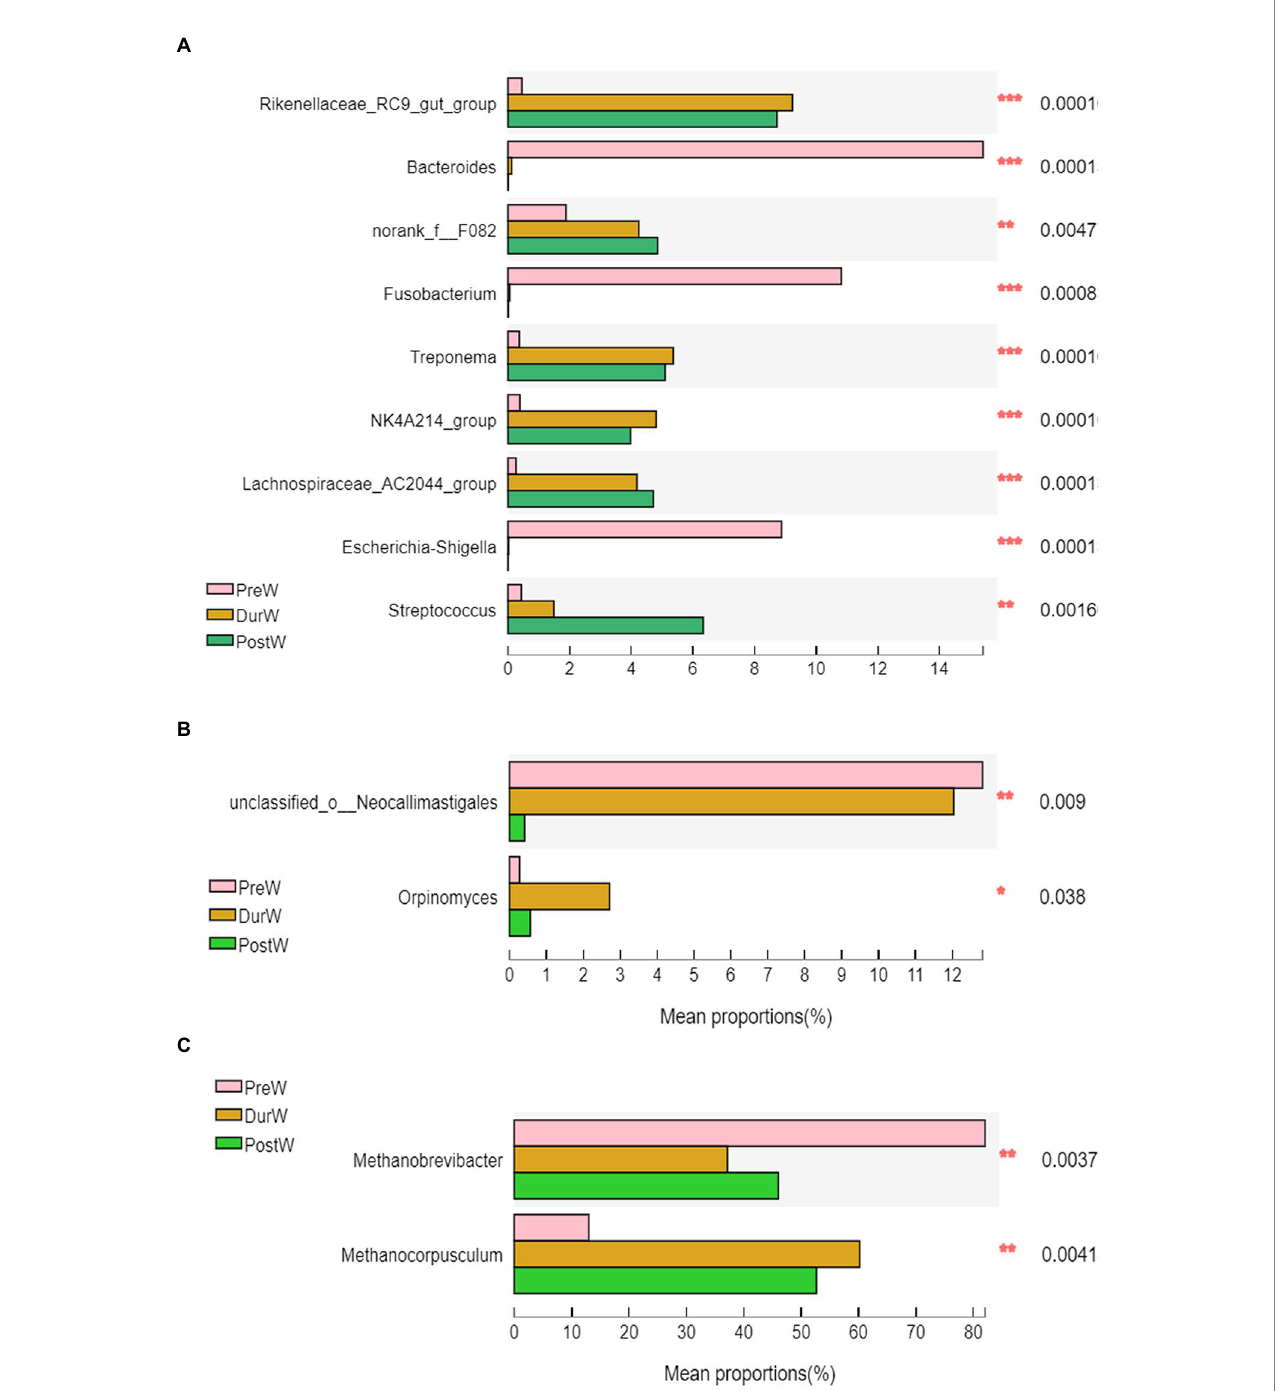
FIGURE 5 Difference of the predominant microbiota at genus level among different groups (abundance of the microbiota is expressed as a percentage). ( A) The different bacteria. ( B) The different anaerobic fungi. ( C) The different archaea; PreW, pre-weaning donkeys; DurW, during weaning donkeys; PostW, post- weaning donkeys; * p < 0.05; ** p < 0.01, *** p